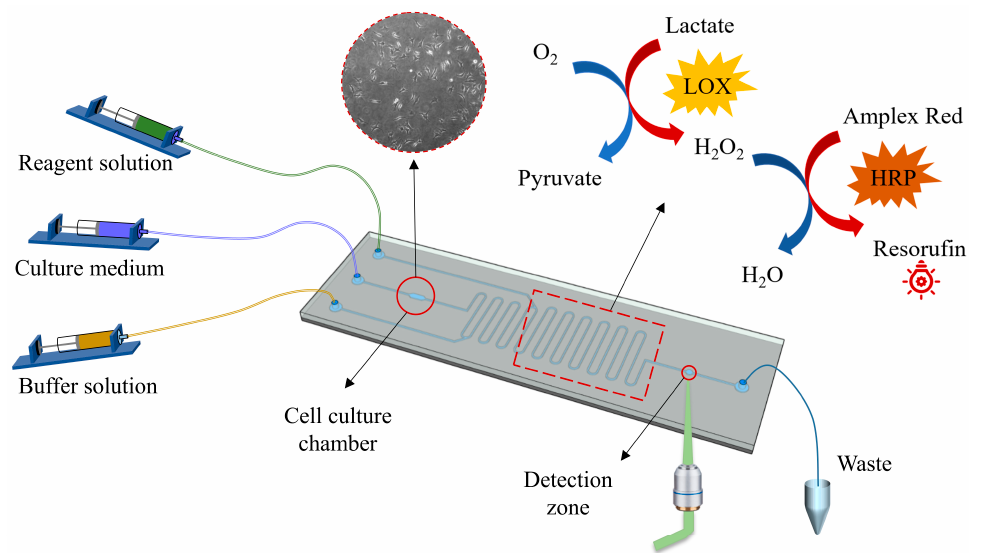
Figure 1. A microfluidic cell culture and detection system. The system includes a fluid driving module, a photographing module, an optical detection module and a microfluidic chip. The photographing module was placed at the bottom of the cell culture chamber, and the optical detection module was placed at the bottom of the detection zone. Moreover, there is a backflow prevention channel between the culture chamber and the detection zone (red rectangle). The size of the microfluidic chip is about 75 mm long and 25 mm wide.